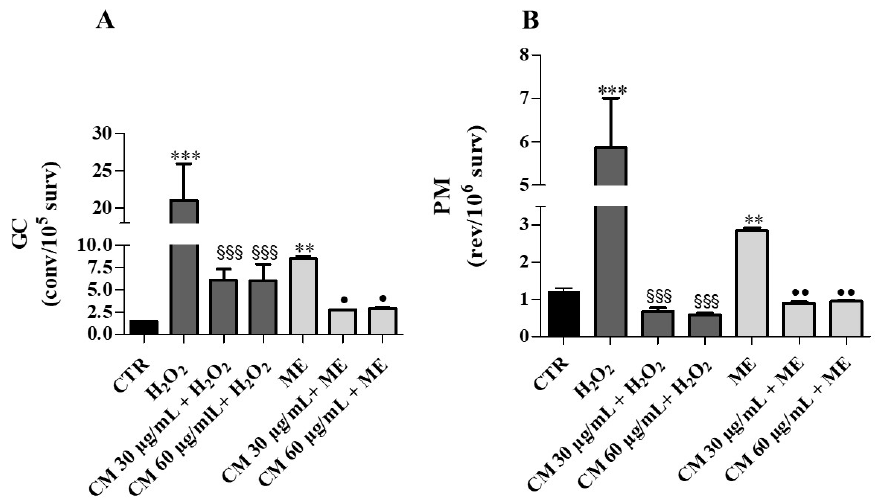
Figure 6. Growth assay: Effects of C. maritimum L. extract (CM) (30 and 60 µg/mL) on Saccharomyces cerevisiae yeast exposed to an oxidative insult by H 2 0 2 (4 mM) and ME (0.15 mM). ( A ), GC frequency expressed as convertants/10 5 survivors; ( B ), PM frequency expressed as revertants/10 6 survivors. Values are expressed as the mean ± SD of three independent experiments, and are analyzed by one– way ANOVA with Tukey multiple comparison test. Significant difference from CTR: ** p ≤ 0.01, *** p ≤ 0.001. Significant difference from H 2 O 2 : §§§ p ≤ 0.001. Significant difference from ME: • p ≤ 0.05, •• p ≤ 0.01.